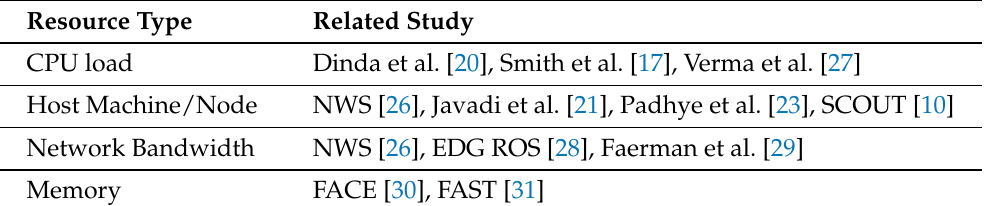
Table 1. Summary of related work on resource performance modeling for distributed